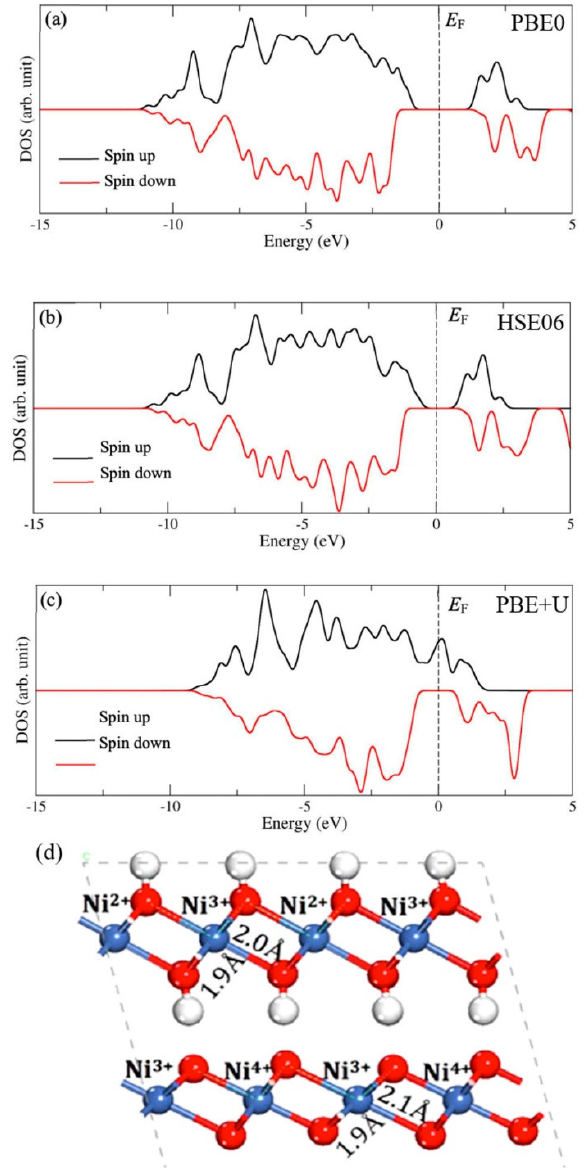
Figure 36. Electronic structures of alternate β-NiOOH. ( a – c ) The density of states with PBE0, HSE06, and PBE+U with U eff = 5.5 eV. The dotted lines represent the Fermi level. ( d ) The OS and bond lengths of Ni ions. (Reprinted from ref. [210] with permission from the Journal of Journal of Physical Chemistry C. Copyright © 2021, American Chemical Society).